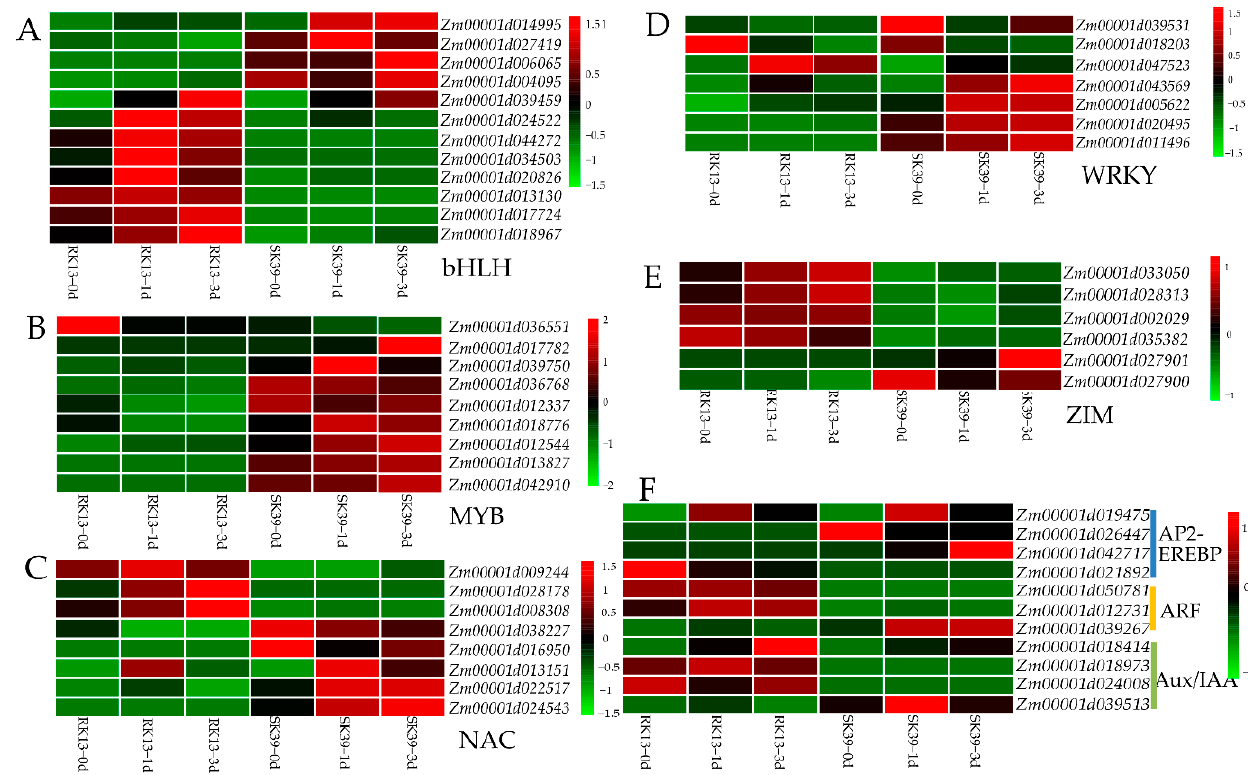
Figure 6. Heatmap of differentially expressed TFs. Red means high expression, green means low expression. ( A ) Gene expression patterns of bHLH TF numbers. ( B ) Gene expression patterns of MYB TF numbers. ( C ) Gene expression patterns of NAC TF numbers. ( D ) Gene expression patterns